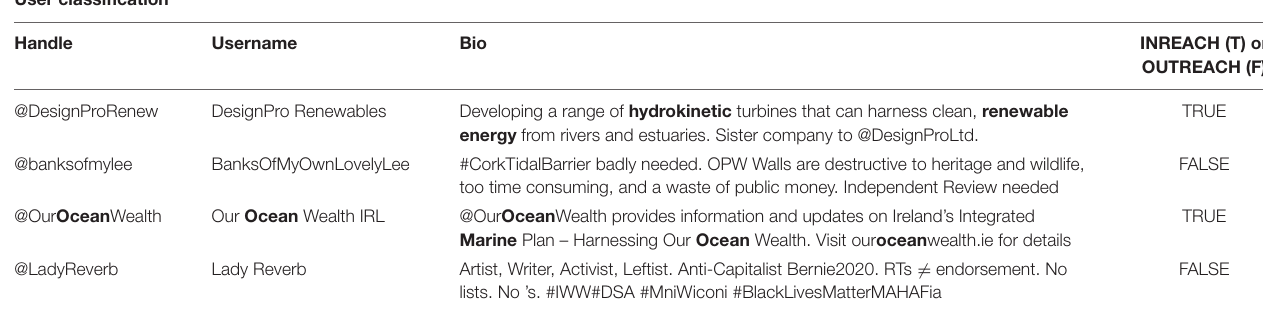
Bolded words indicated words or phrases that triggered the algorithm.